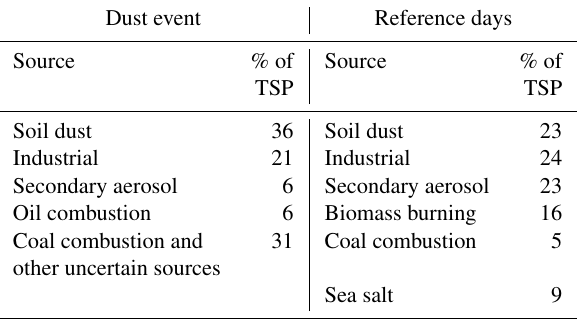
Table 6. Sources and source contributions (expressed in %) calcu- lated for aerosol samples collected during dust and non-dust events.